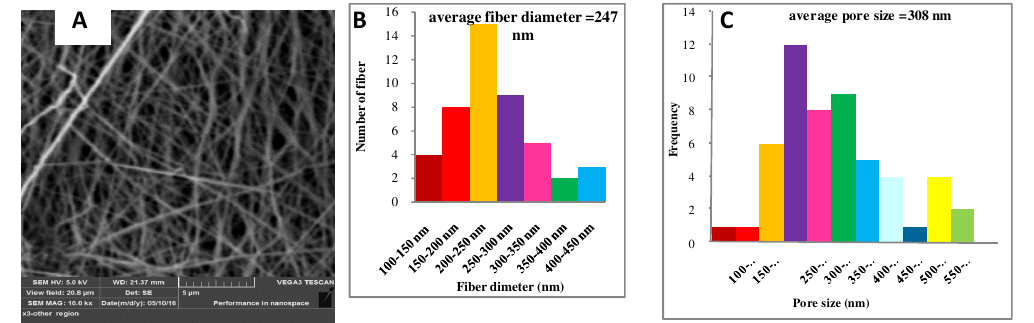
Fig. 9. (A) SEM image of (AgNO (C) pore size distribution.